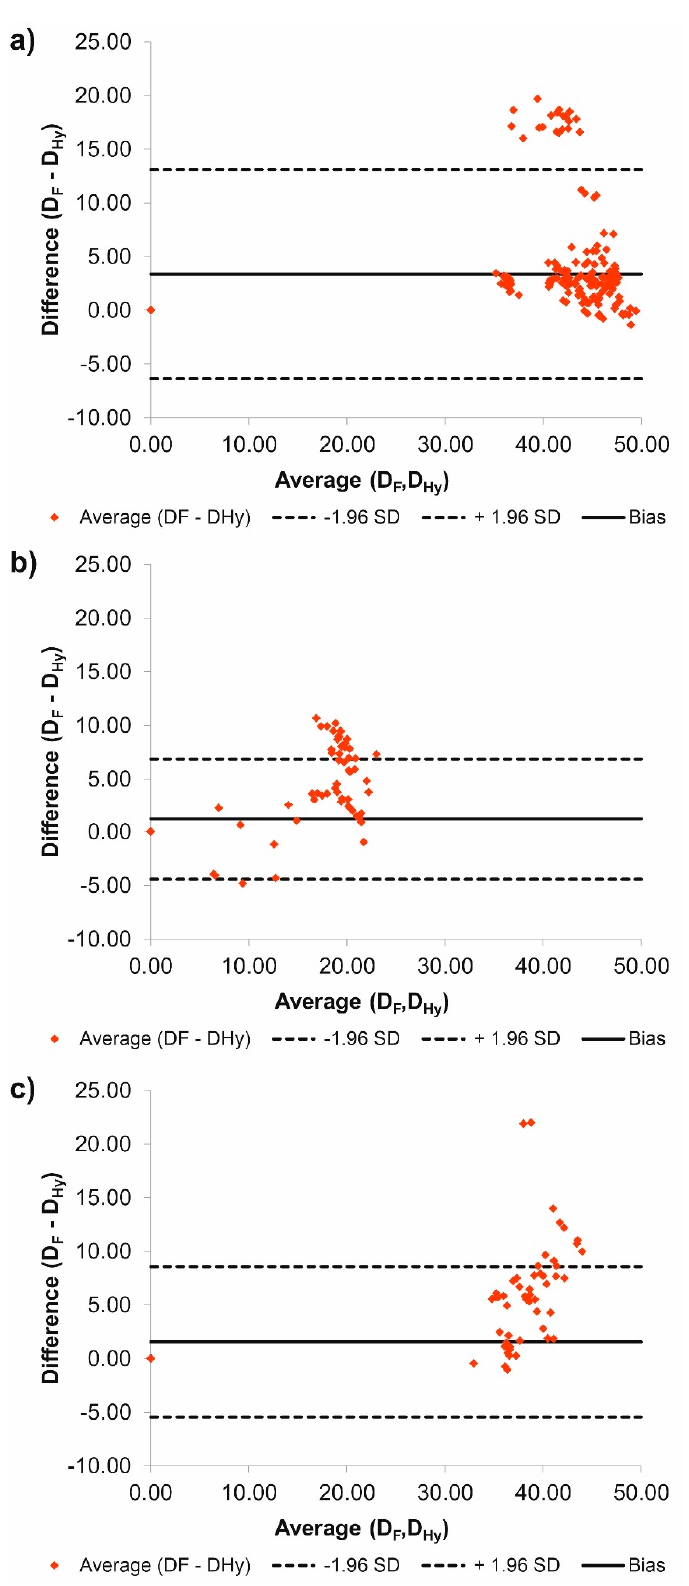
Figure 2. Comparison of D F and D Hy with the use of Bland-Altman analysis for: ( a ) Common duct, ( b ) true duct, and ( c ) false duct. For all analyzes p > 0.05.